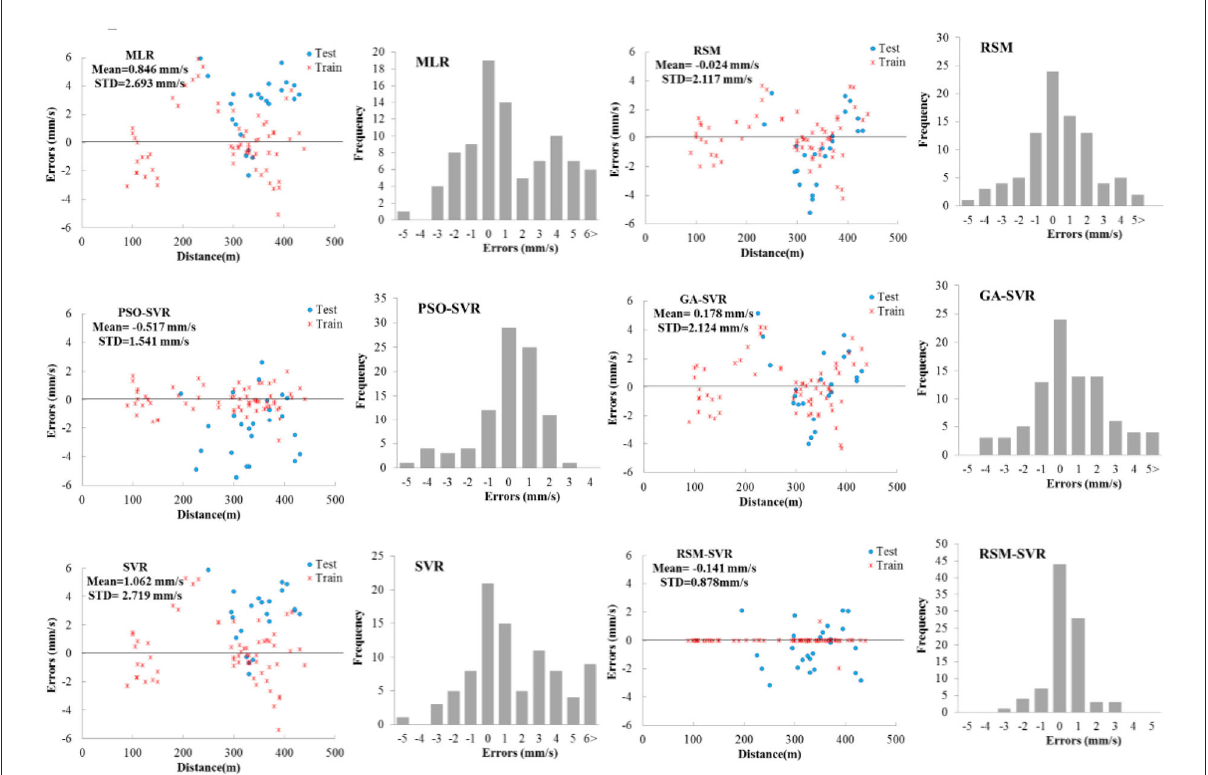
FIGURE4 Errors ( PPV exp - PPV Pre ) of predictive models shown in bar diagrams, corresponding to